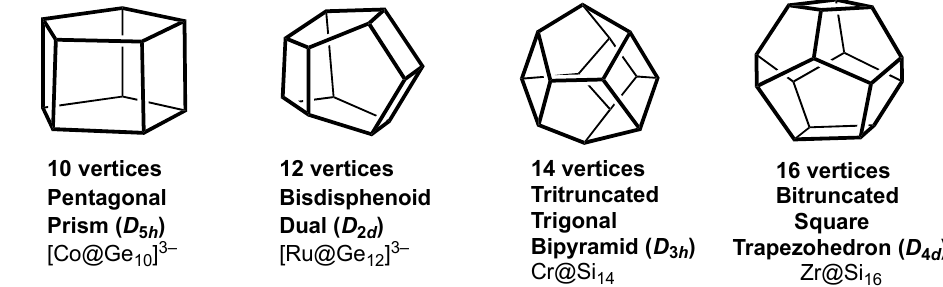
Figure 6. The most spherical trivalent polyhedra with 8, 10, 12, 14, and 16 vertices as duals of the closo deltahedra in endohedral Group 14 clusters.